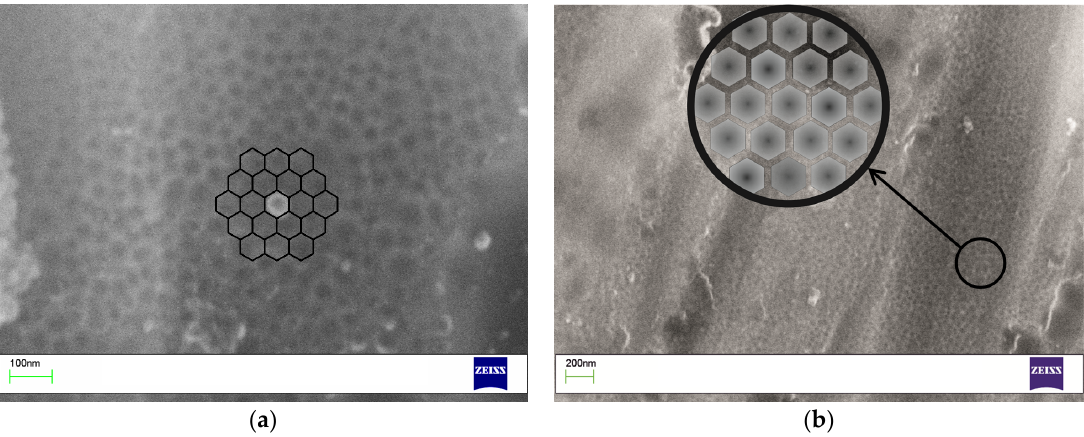
Figure 2. ( a ) SEM image of the Fe70Cr15B15 alloy after abrasion and anodization in IL for 100 s ( i = 12.5 mA cm −2 ) before electrochemical anodic oxidation in an 0.1 M Na 2 SO 4 aqueous solution; ( b ) SEM image of the Fe70Cr15B15 alloy after abrasion, anodization in IL for 100 s ( i = 12.5 mA cm −2 ), and electrochemical anodic oxidation in the 0.1 M Na 2 SO 4 aqueous solution.